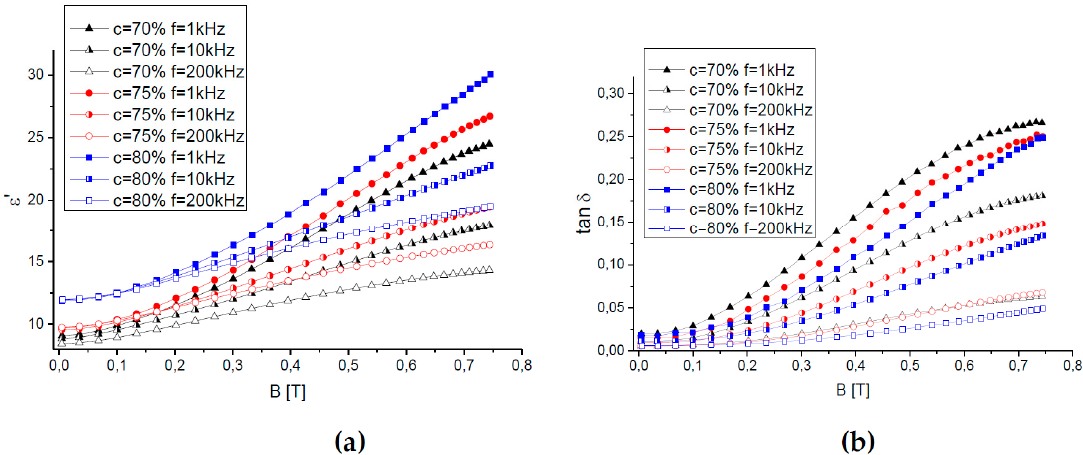
Figure 2. Dependence of ( a ) the relative lossless permittivity and ( b ) the dielectric loss on the magnetic field for MAEs samples measured at different frequencies of the current between electrodes.